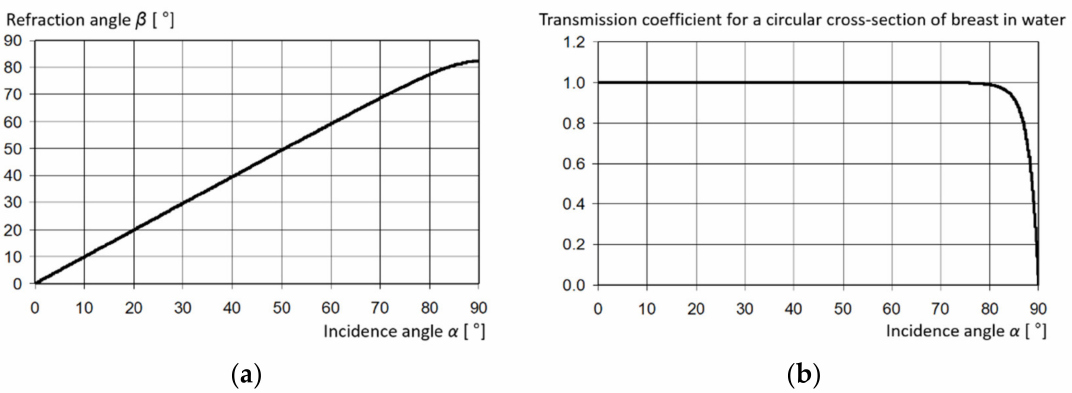
Figure 1. Dependence of: ( a ) angle of refraction of the ultrasonic wave at the water/breast interface from the angle of incidence; ( b ) coefficient of transmission of the ultrasonic wave D p through a circular cross-section of a breast immersed in